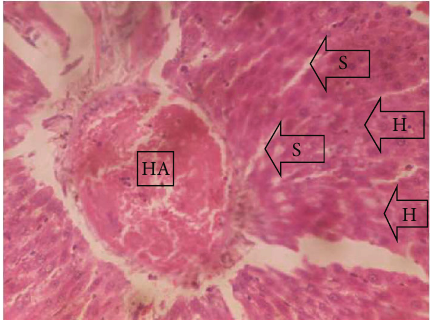
Figure 1: Photomicrographs of the normal liver of the group I rats showing intact hepatocytes (H), sinusoids (S) containing Kup ff er cells, and congested hepatic artery